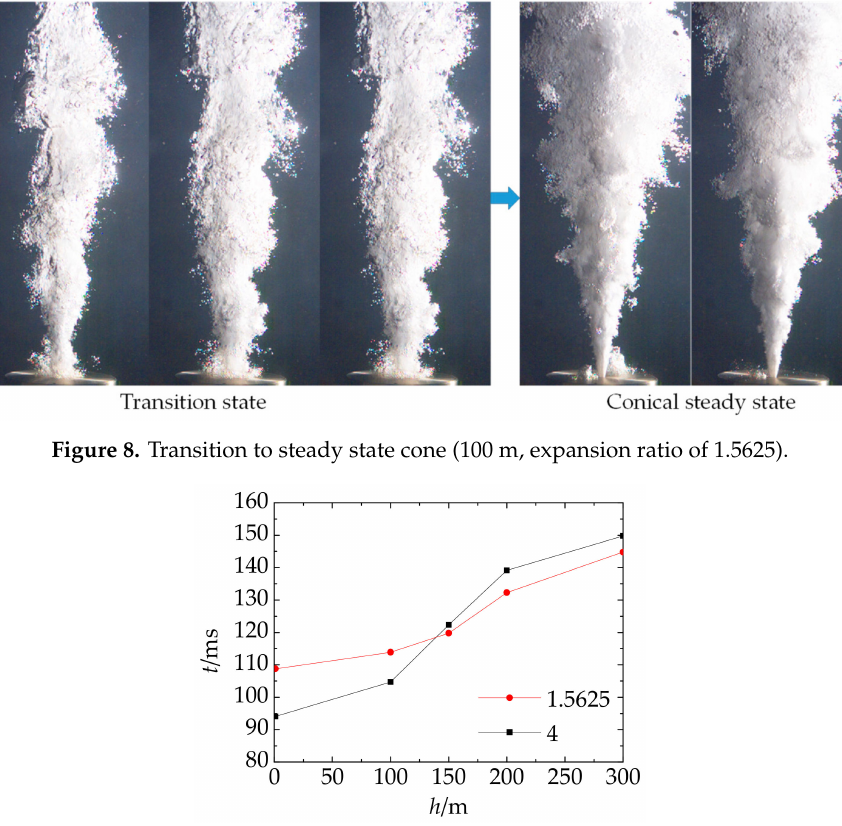
Figure 9. Lasting time to steady